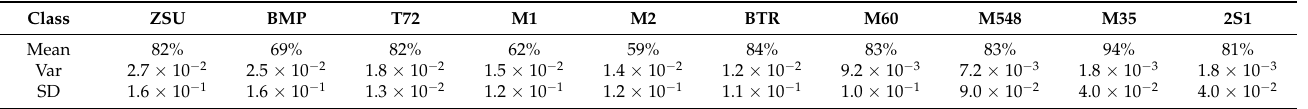
Table 8. Simple net feature fusion intraclass variance (Var) and standard deviation (SD).